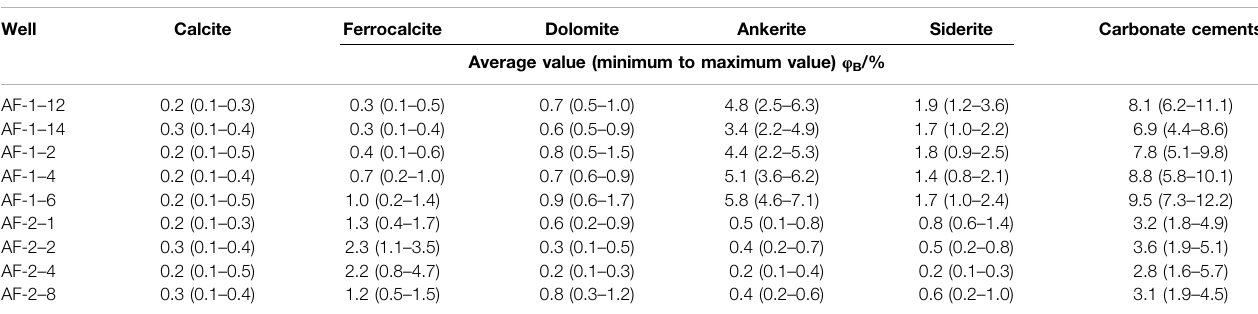
TABLE 2 | Volume fraction of carbonate cements in the Huangliu